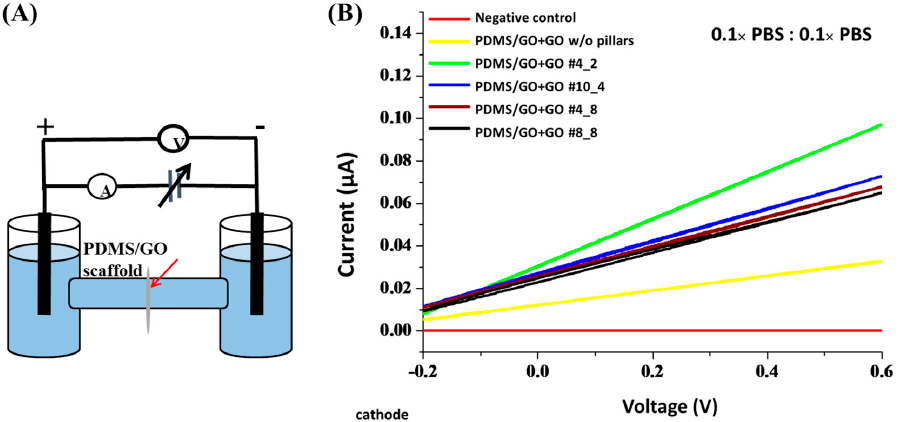
Figure 7. Permeability measurements of the PDMS/GO + GO scaffolds with generation of different micropillars. ( A ) Illustration of the equipment setting for the permeability measurement of PDMS/GO scaffolds. The membrane samples were placed between the cathode ( − ) and anode (+) chamber. w/o: without. ( B ) The current (I) ‐ voltage (V) curves of PDMS/GO + GO membranes.